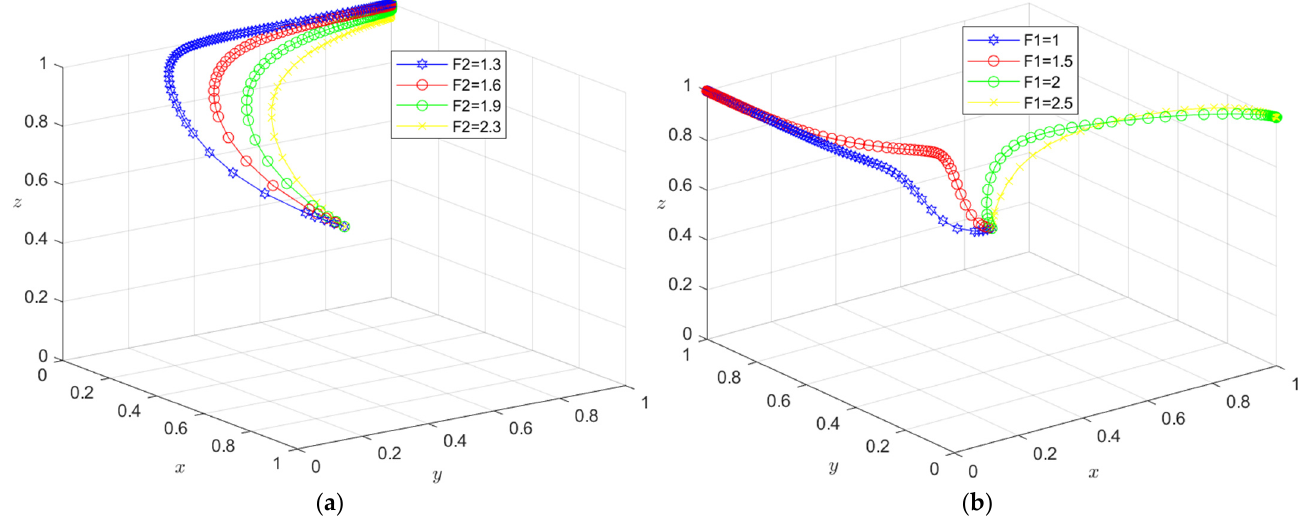
Figure 10. ( a ) Evolution path of the developer, general contractor, and government under different government punishments F 2 . ( b ) Evolution path of the developer, general contractor, and government under different government punishments F 1